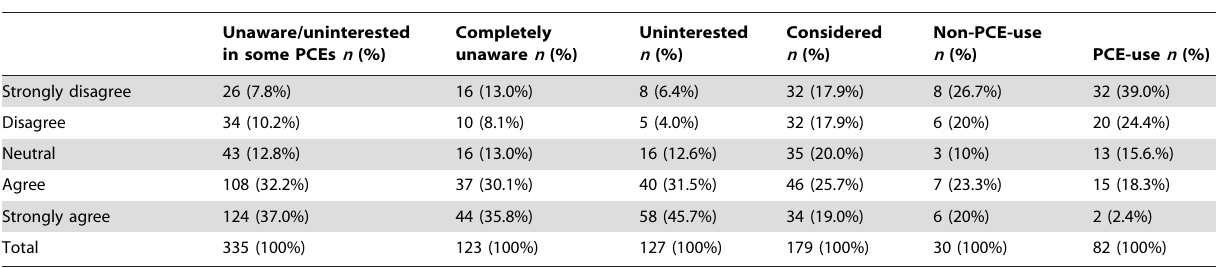
Table 9. PCE in academia is ethically problematic ( n =